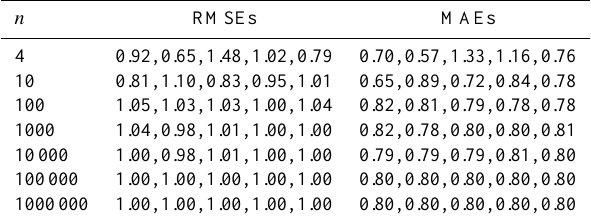
Table 1. RMSEs and MAEs of randomly generated pseudo-errors with a zero mean and unit variance Gaussian distribution. Five sets of errors of size n are generated with different random